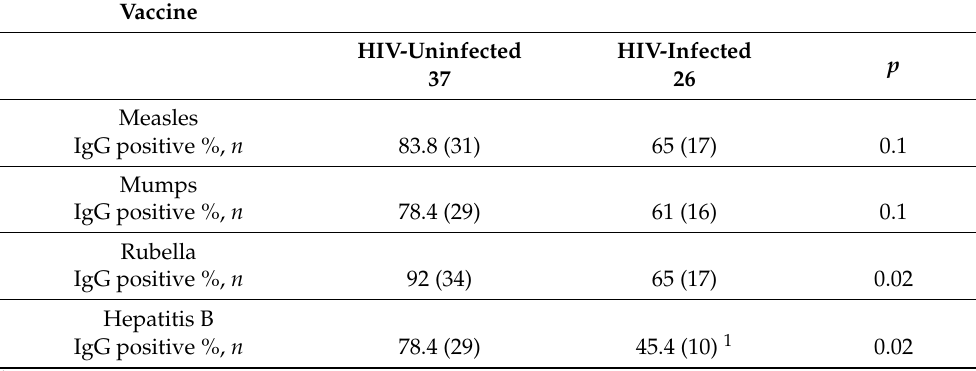
Table 3. Protection rate against measles, mumps, rubella and Hepatitis B in HIV and control at